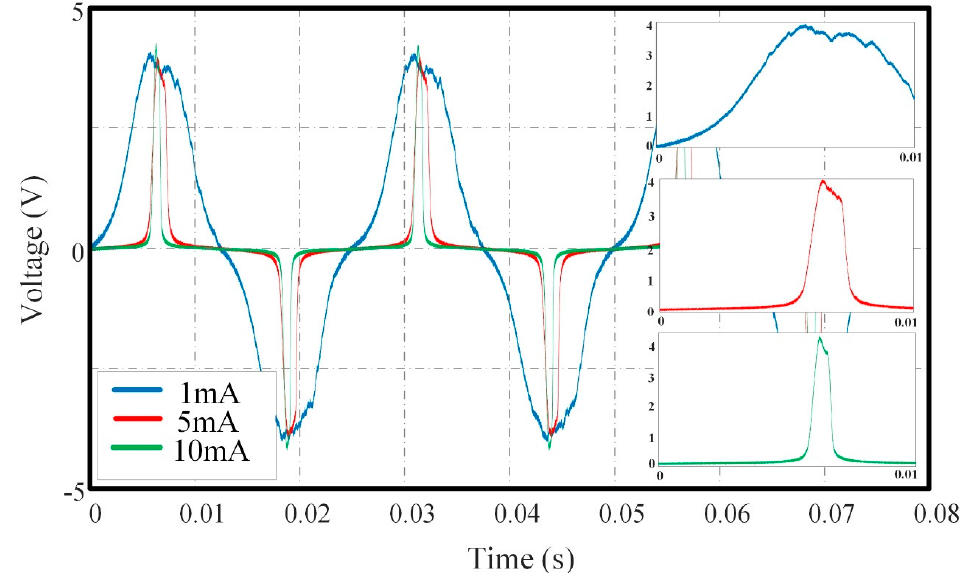
Figure 3. Induced voltage of RTD fluxgate sensor with excitation frequency of 40 Hz and different excitation amplitude of 1 mA, 5 mA and 10 mA.